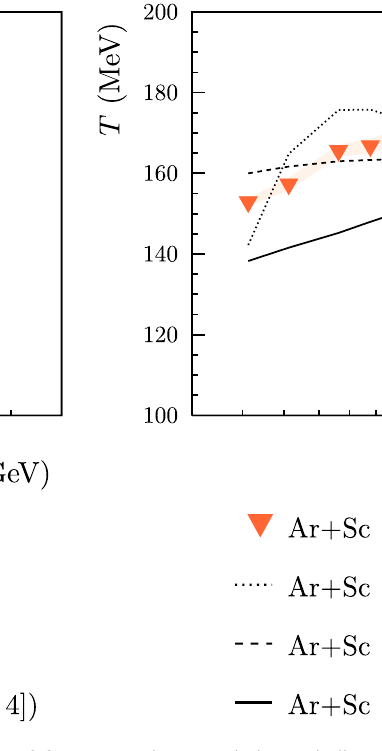
tematic uncertainties are indicated by shaded bands (or caps for Pb+Pb collisions). Right: comparison of the results for Ar+Sc collisions as pre- sented in the left plot with Epos , U r qmd and Hijing model calculations (black curves)